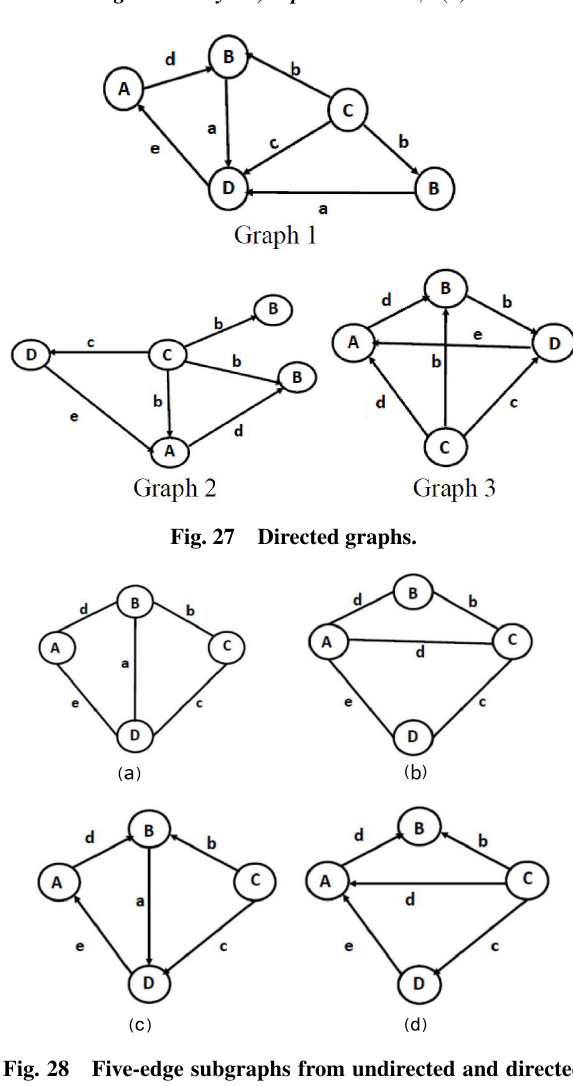
Fig. 28 Five-edge subgraphs from undirected and directed